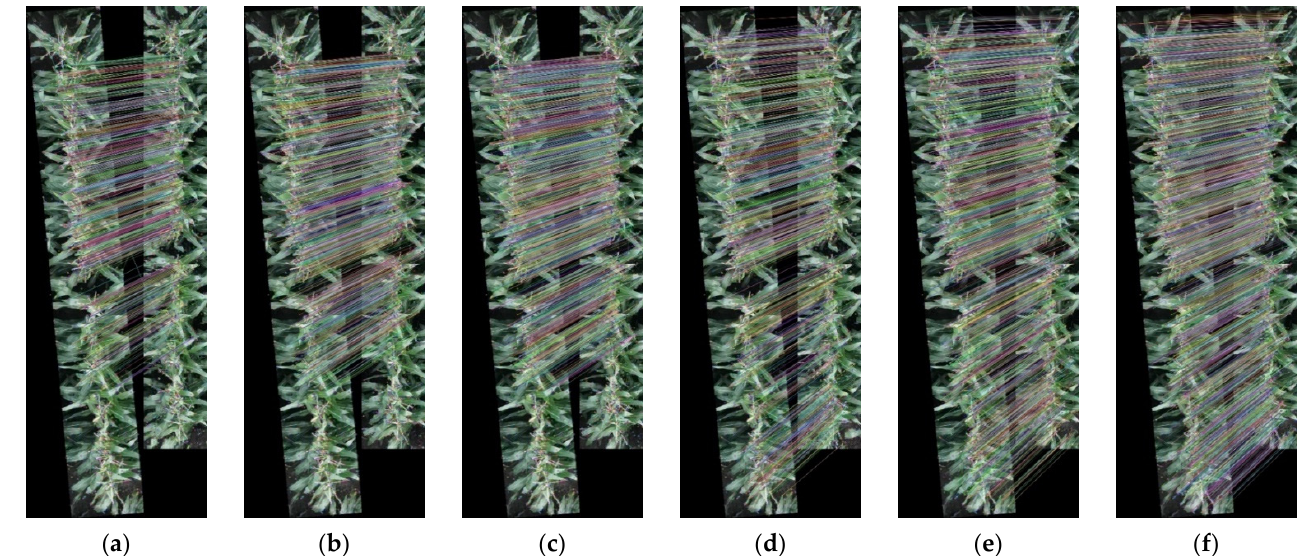
Figure 17. SIFT-based matchings between the original frame image (left) and generated orthophoto for a given row segment using different DSM smoothing and seamline control strategies (right) for: ( a ) orthophoto i, ( b ) orthophoto ii, ( c ) orthophoto iii, ( d ) orthophoto iv, ( e ) orthophoto v, and ( f ) orthophoto vi.